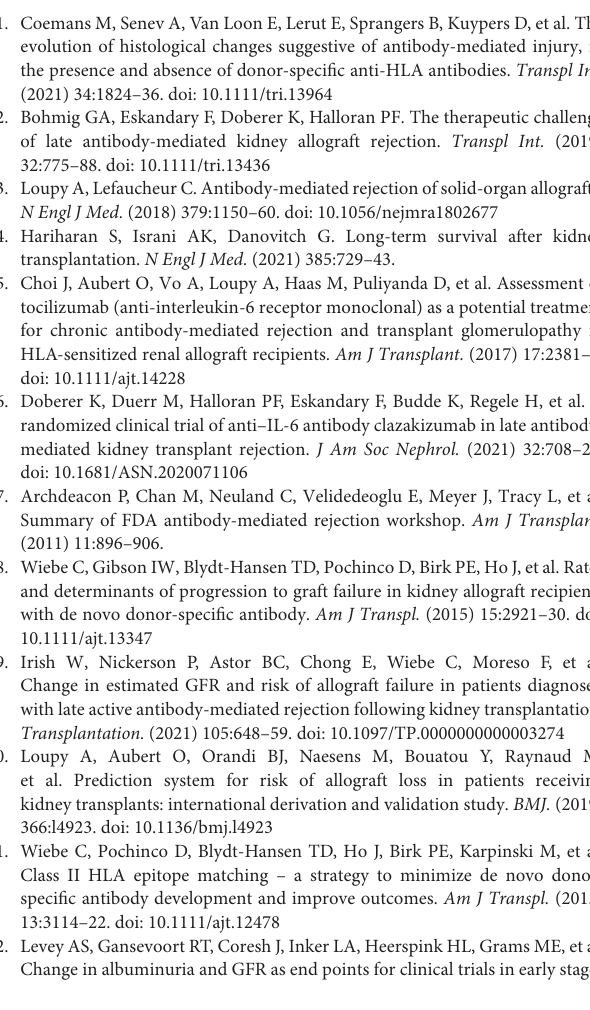
Supplementary Figure 1 | Bar charts with percentages of the HLA class I and class II antigens that the corresponding DSA were directed against. Since some patients had > 1 DSA within either HLA class, percentages do not perfectly match with the given percentages of class I and/or class II DSA at the time of iBx in Table 2 and Supplementary Table 2 . Supplementary Figure 2 | Kaplan-Meier plots of the total cohort ( N = 70) for patient survival since transplantation (A) and since index biopsy (B) . Supplementary Figure 3 | It shows the single eGFR measurements (green dots), the individual eGFR trajectories (gray solid lines) as well as the overall trajectory (red solid line) of the antibody-verified cohort ( N = 55). The linear mixed effects model (LME) was carried out over a course of 2 years (A) from − 12 to 12 months with intercept at time of iBx and over the course of 3 years (B) from -12 to 24 months with intercept at the time of iBx. The shown overall trajectory is based on the fixed effects of the LME, whereas the individual trajectories also include the random effects. Supplementary Figure 4 | Forest plots for the antibody-verified cohort ( N = 55) with landmarks set at 12 or 24 months after iBx to avoid immortal time bias. Hazard ratios (HR’s) and their corresponding 95% confidence intervals (95% CI) are shown on the right. GN, glomerulonephritis; TCMR, T cell-mediated